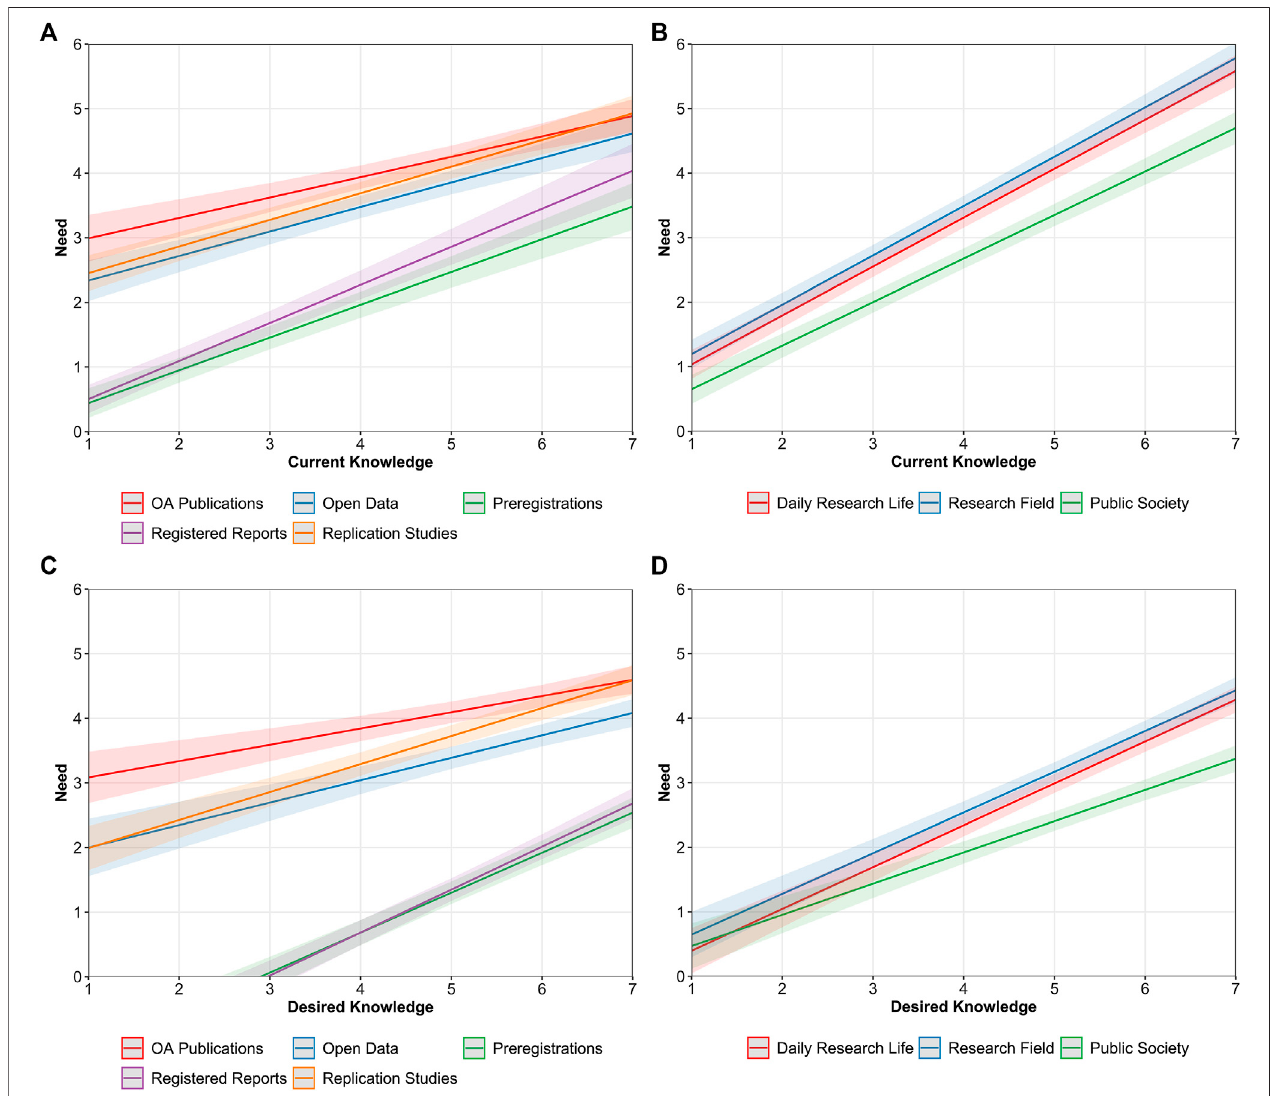
FIGURE7| Predicted values ofperceived needas afunction ofECRs ’ currentknowledgeacrossOSpractices (A) and differentperspectives (B) and asafunction of desired knowledge across OS perspectives (C) and different perspectives (D) . Bandwidths represent 95% con fi dence intervals (CIs).